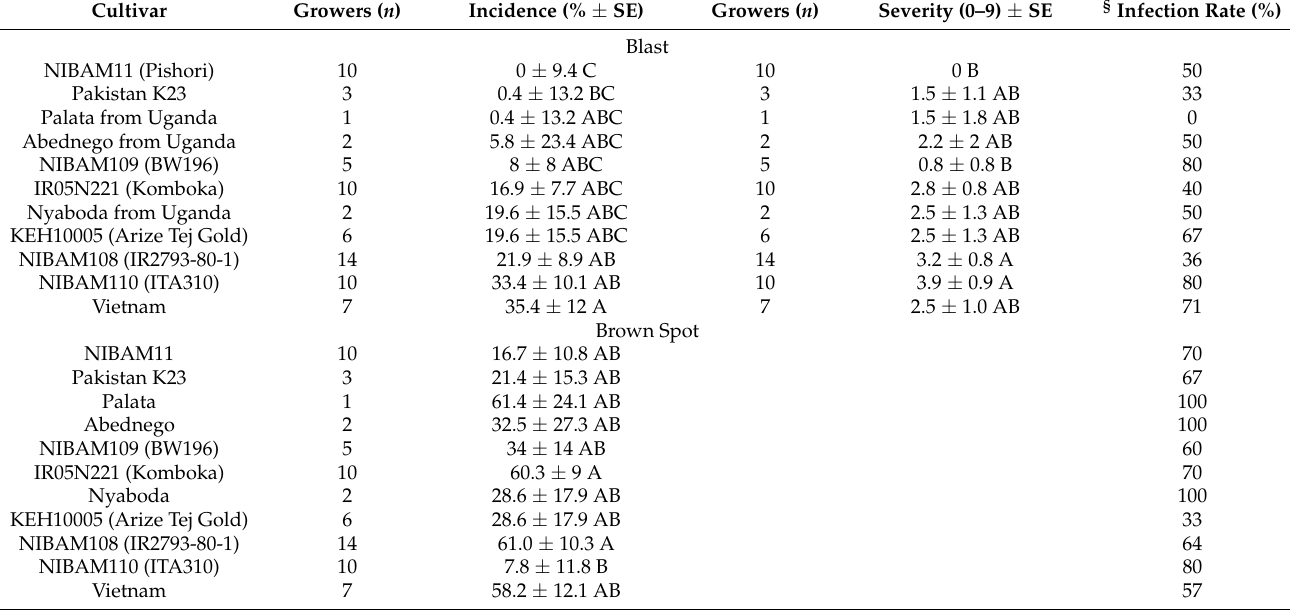
Figure 3. Association between growers’ awareness of rice blast disease symptoms and the incidence ( A ) and severity ( B ) of blast and incidence of brown spot ( C ) disease. Table 4. Incidence and severity of blast and brown spot disease among the popular rice cultivars surveyed in Busia and Kisumu Counties of Kenya in